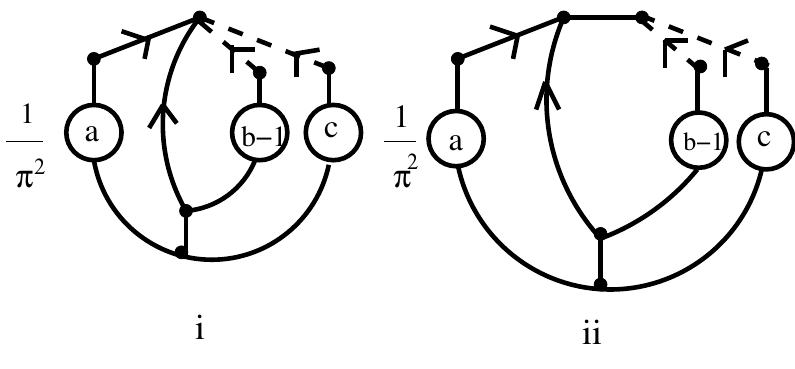
Figure 34 . (i) Q 2 ( a; 1 j b; c ) and (ii) S 1 ( a; 1 j b; c